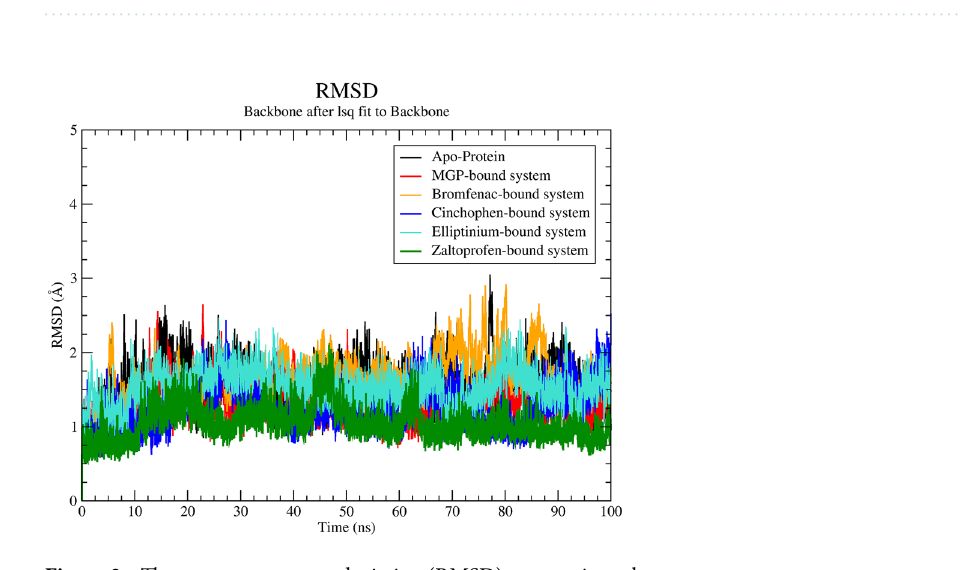
Table 2. Various Characteristics of the L Protein and Ligands. *BB: backbone atoms, **Avg: average.